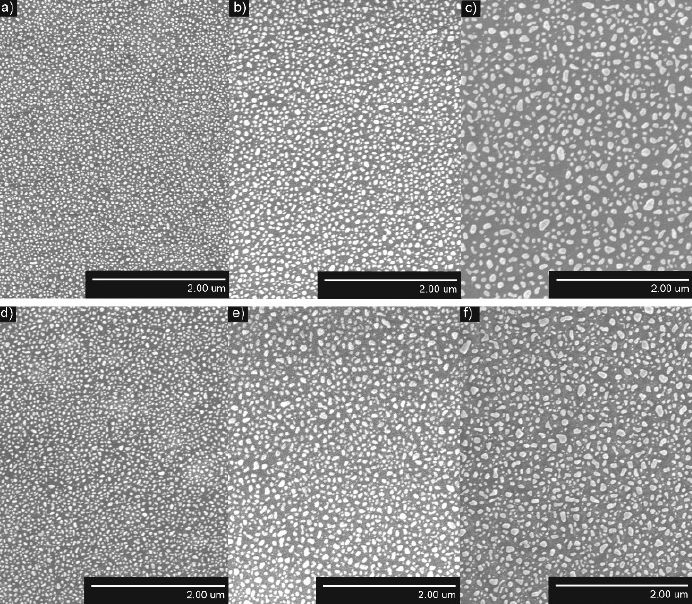
Figure 4. SEM images of AuNP after annealing ( T a = 500 °C) of Au/TiO 2 thin films system: ( a ) h = 5 nm, as-deposited TiO 2 ; ( b ) h = 7.5 nm, as-deposited TiO 2 ; ( c ) h = 10 nm, as-deposited TiO 2 ; ( d ) h = 5 nm, T TiO2 = 500 °C; ( e ) h = 7.5 nm, T TiO2 = 500 °C; ( f ) h = 10 nm, T TiO2 = 500 °C.